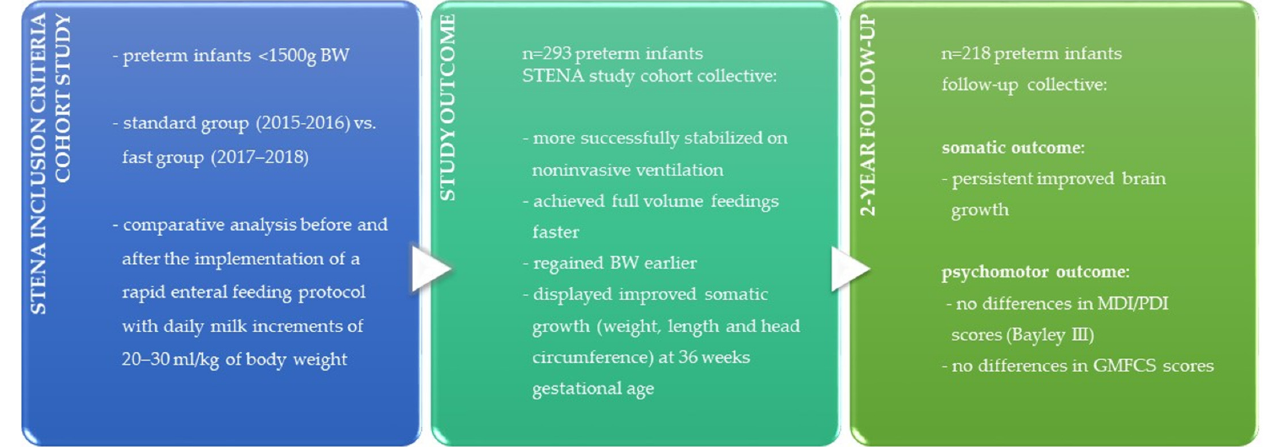
Figure 1. Summary of the main (significant) STENA cohort study results including the results from the previous publication on the short-term outcomes before discharge from the NICU [20].